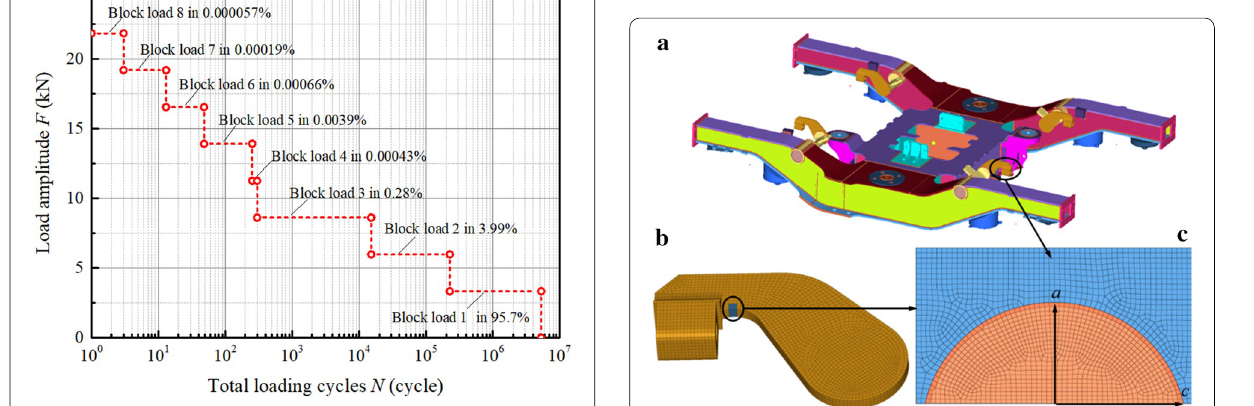
Figure 4 Eight-stage braking load spectrum obtained from the Wuhan–Guangzhou line of the CRH EMU